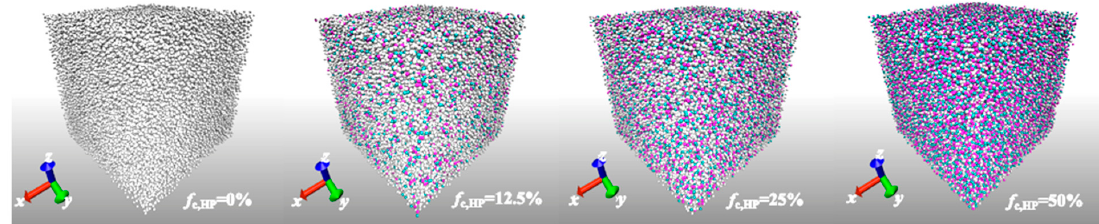
Figure 1. Morphology of ionic homopolymers (HPs) with varying charge ratio f c ,HP from 0% to 50%, where the neutral monomers are in white, the charged monomers in red and charged counterions in cyan.